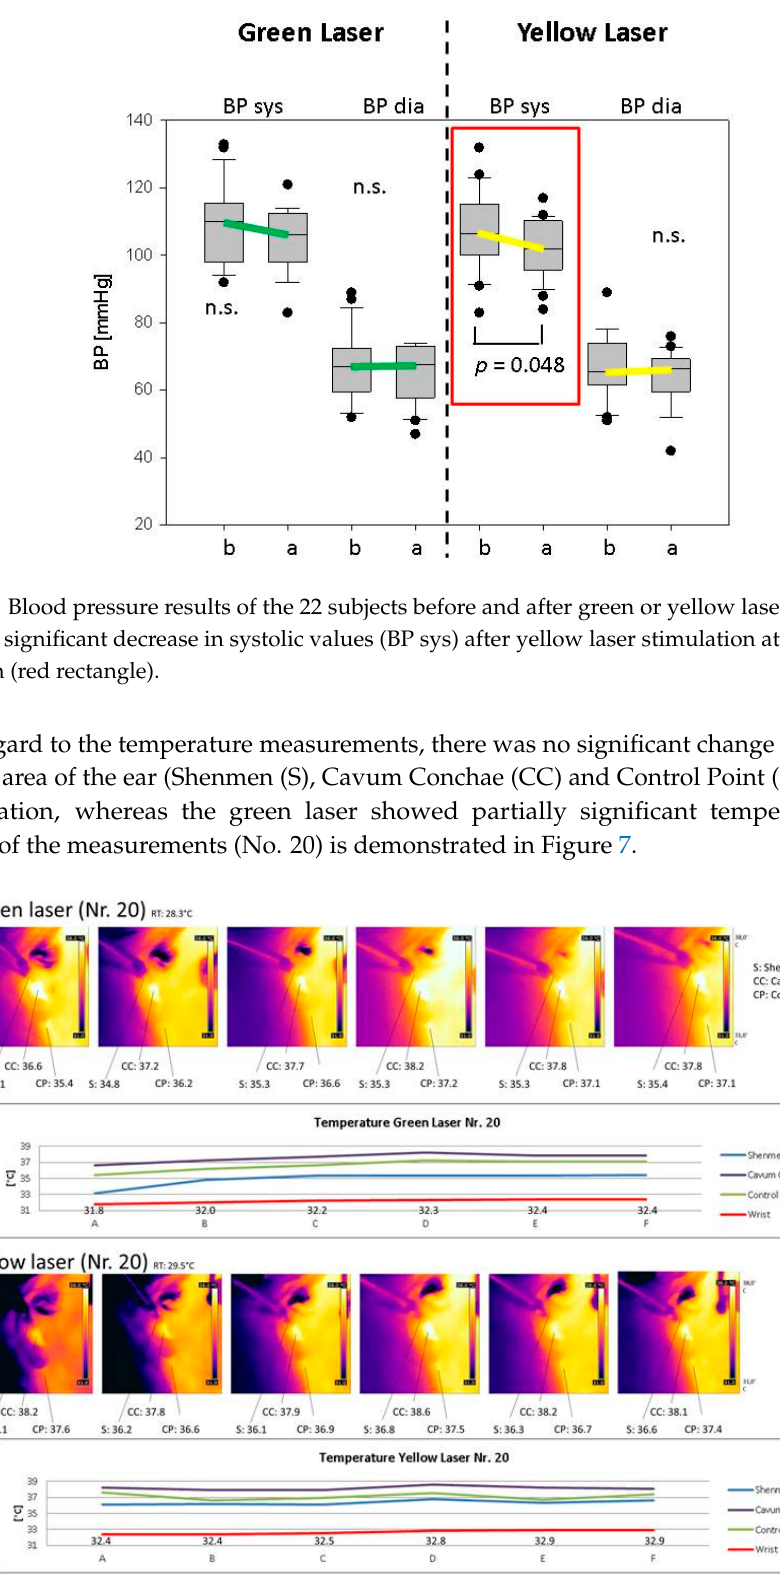
63.9 ± 12.9 cm/s; v m before yellow laser: 62.4 ± 12.0 cm/s; v m after yellow laser: 62.2 ± 12.9 cm/s).